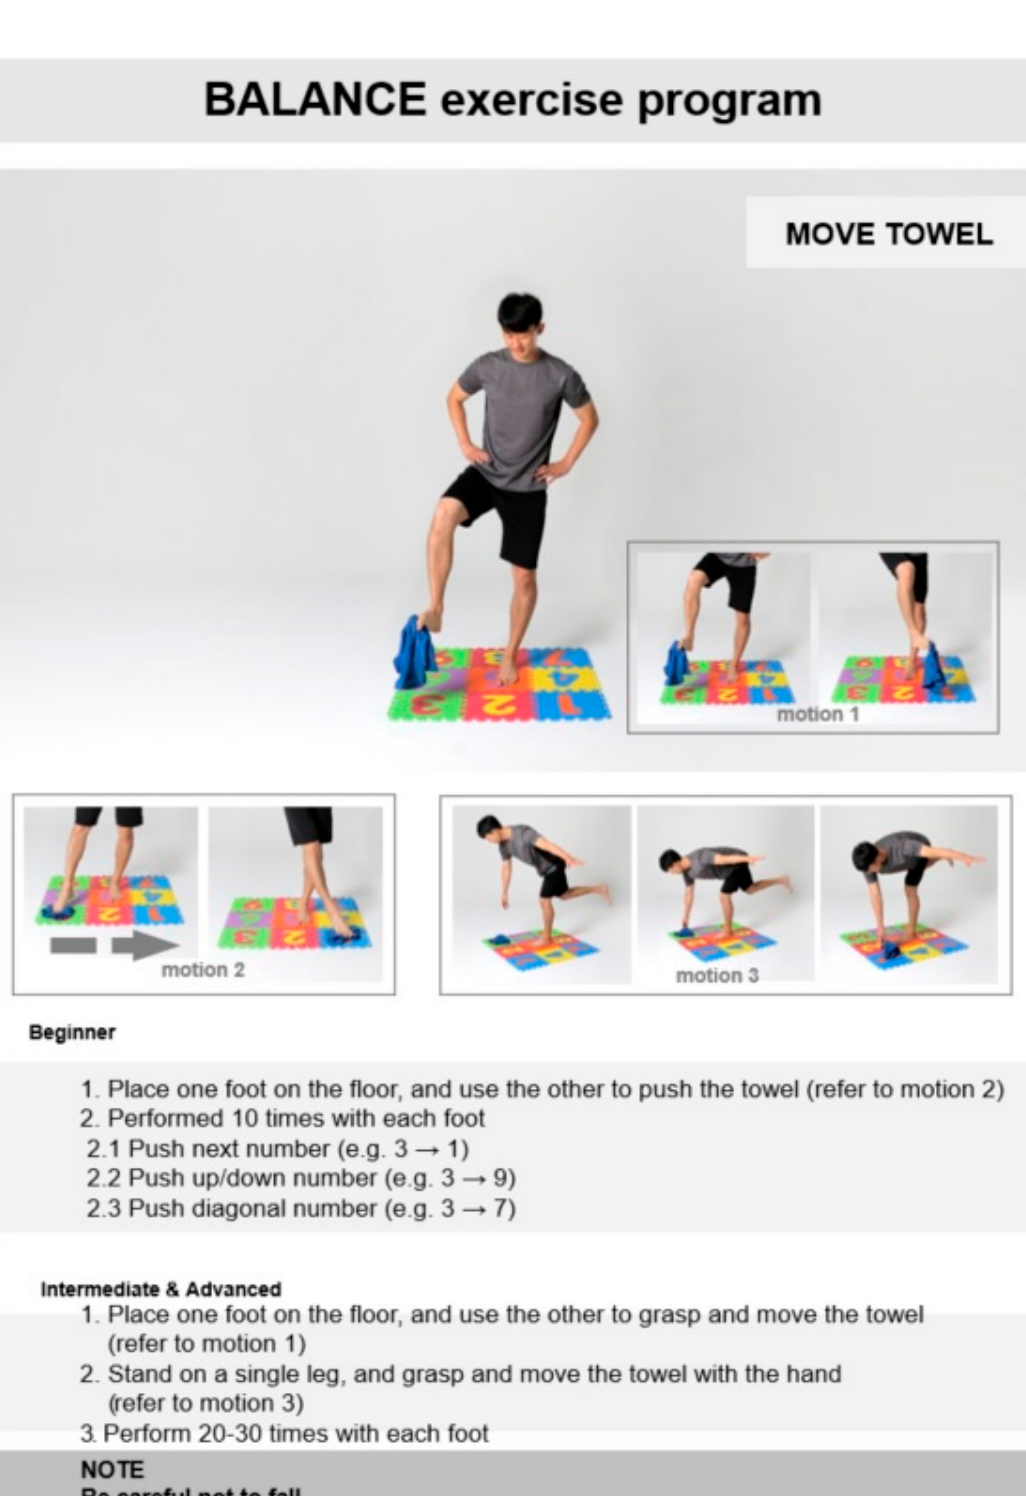
Figure A20. Detailed description and components of each movement in the “Move towel” balance exercise.